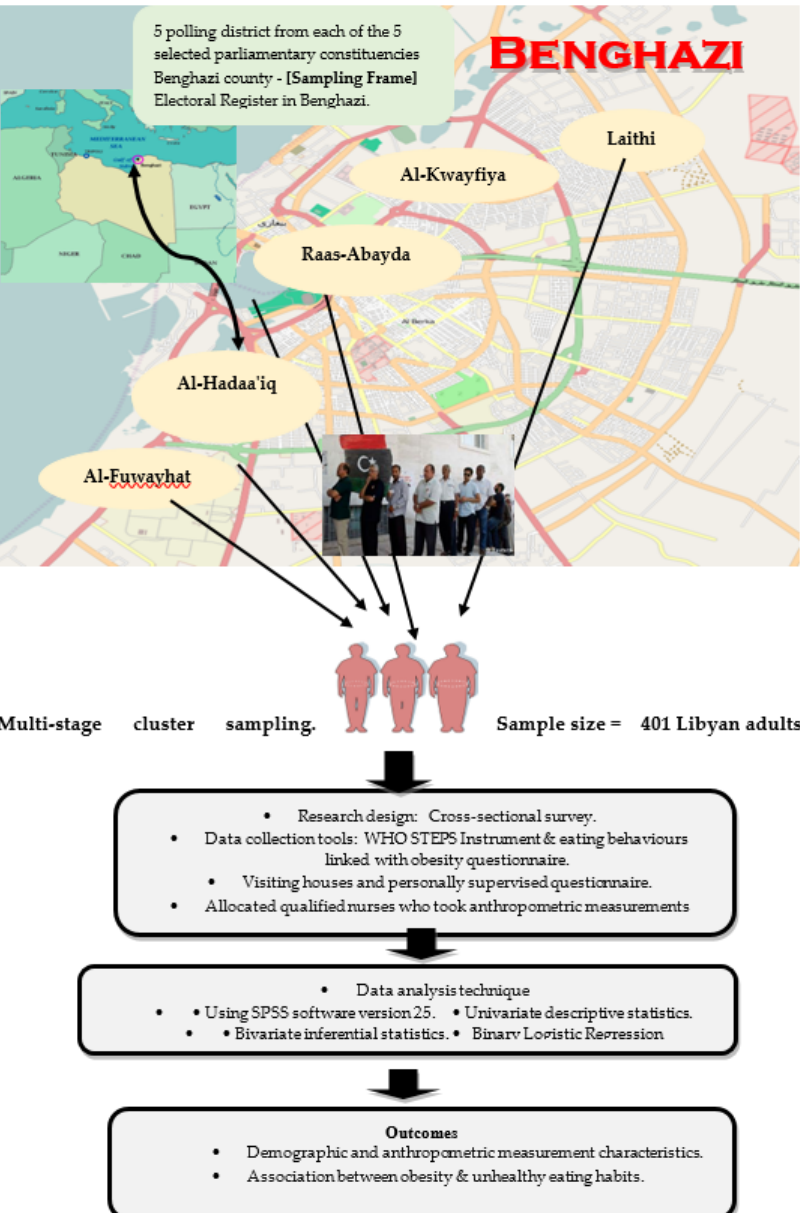
Figure 1. A graphical scheme of study design.